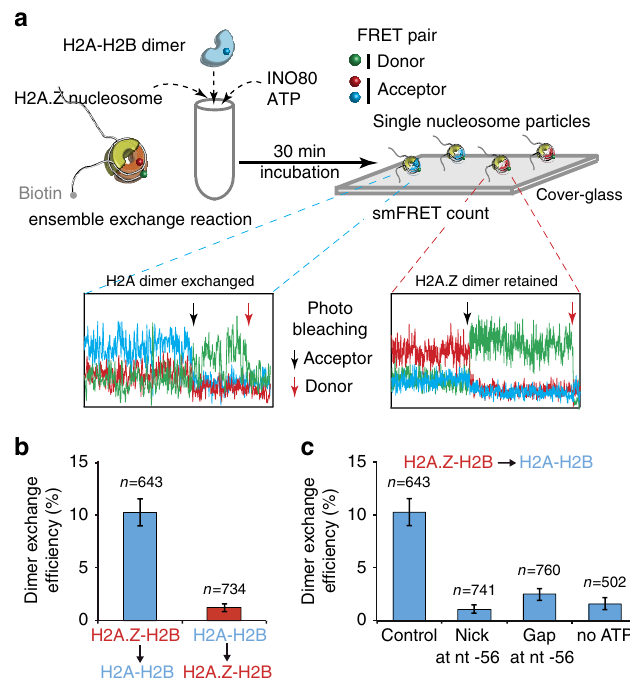
Figure 5 | INO80 requires DNA translocation for exchanging H2A.Z for H2A in nucleosomes. ( a ) Experimental scheme to determine the efficiency of INO80 for dimer exchange at single-nucleosome level, based on three- colour FRET. Nucleosomes forming FRET pairs with Cy3 (DNA) and Cy5.5 (H2A–H2B dimer) or ATTO 647N (H2A.Z–H2B dimer) were counted to measure the efficiency of dimer exchange. The acceptor is photo-bleached at a single time point (black arrow), which is followed by a single-step donor (Cy3) photobleaching (red arrow). ( b , c ) The results are shown for efficiencies of H2A–H2B incorporation and H2A.Z–H2B incorporation ( b ), and the effects of a single nucleotide gap or nick at nt (cid:2) 58 or the absence of ATP on H2A–H2B incorporation ( c ). The number of single molecules ( n ) analysed for each reaction condition is shown above its corresponding